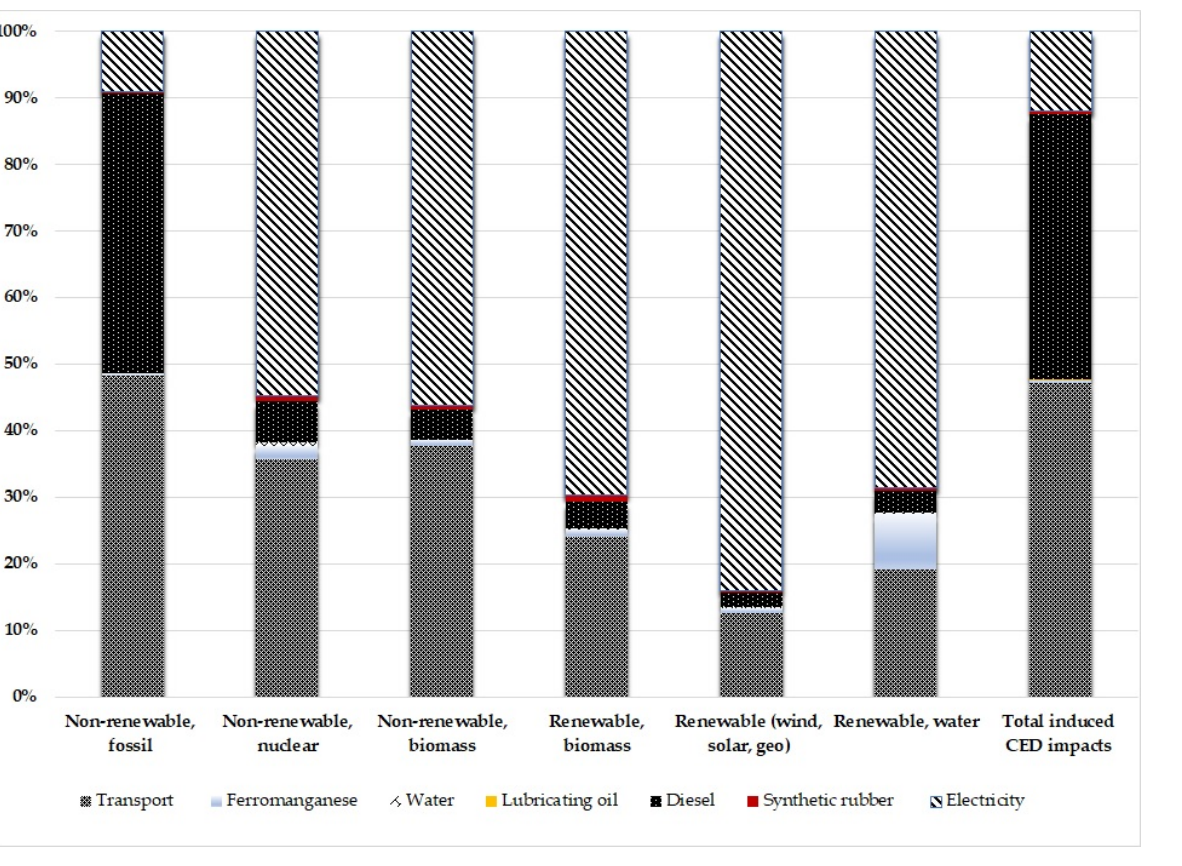
Figure 4. Percentage values of induced CED impacts associated to collection and recycling of 1 tonne of C&DW (from Table 3). Note: Renewable category comprises wind, solar and geothermal (wind, solar,